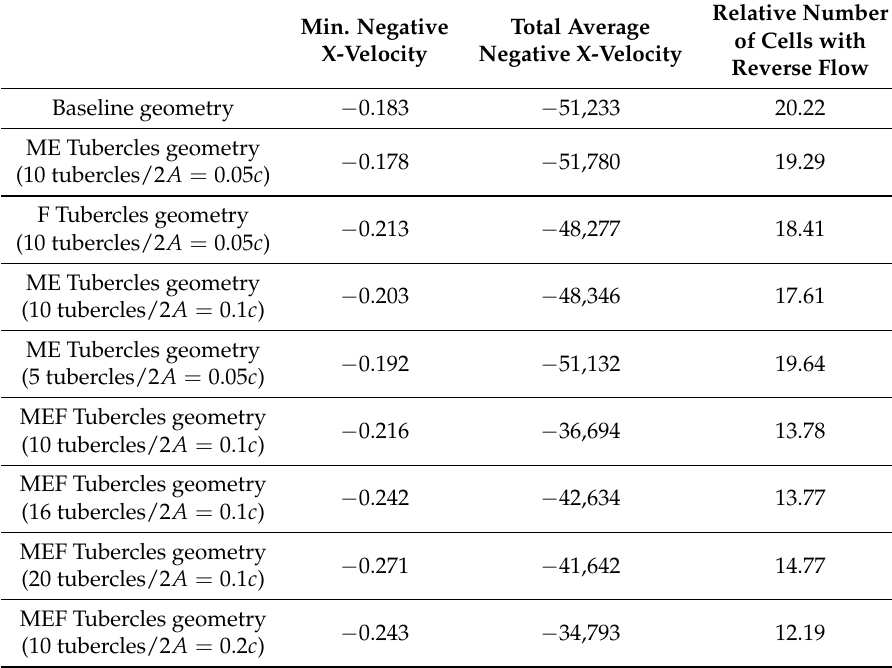
Table 9. Main characteristics of the separated flow over the front wing Part